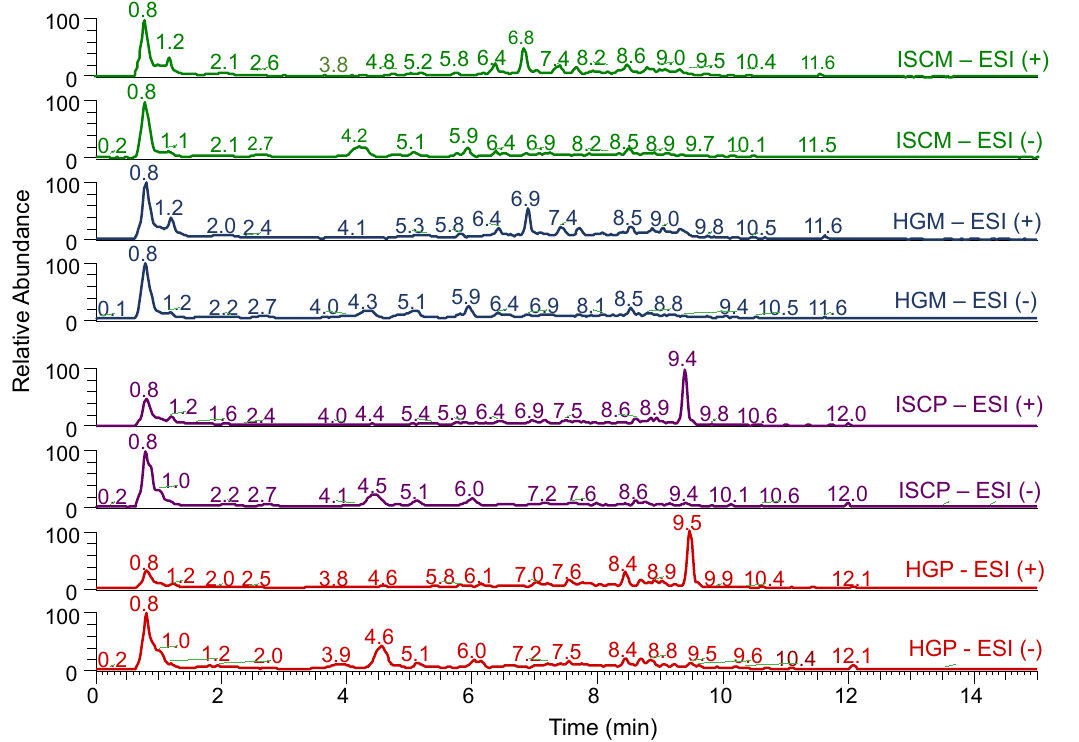
4 of 15 Figure 1. Metabolites in the fermented aqueous extracts of V. album putatively annotated by LC- HRMS/MS according to the ionization mode and chemical group. Metabolites annotated in the extracts were classified as i) primary metabolites, such as amino acids and peptides ( n = 38); organic acids ( n = 17); monosaccharides sugar acids and sugar alcohols ( n = 10); fatty acids ( n = 10); nucleobases/nucleosides ( n = 8); and ii) secondary metabolites, such as flavonoids ( n = 53); phenolic acids ( n = 35); terpenoids ( n = 20); coumarins ( n = 5); and other compounds ( n = 16), as shown in the Figure 1. Dipeptides were the most abundant compounds in the group of amino acids and peptides. A total of 23 dipeptides were annotated. They were observed in the ESI+ analysis as proton adducts and their MS/MS spectra showed losses of H 2 O and CO from the precursor ions. To the best of our knowledge, this class of compounds has never been described in Viscum samples. However, their presence may not be a surprise since these fermented aqueous extracts were rich in protein content. Examples of dipeptides found were Leu-Leu, Ile-Ile, Leu/Ile-Thr, etc. In addition, one tripeptide Leu/Ile-Pro-Leu/Ile with fragments at m/z 70.07, 86.10, 116.07, 183.15, and 211.14 was also annotated. Organic acids were observed at the beginning of the chromatographic analysis. Their